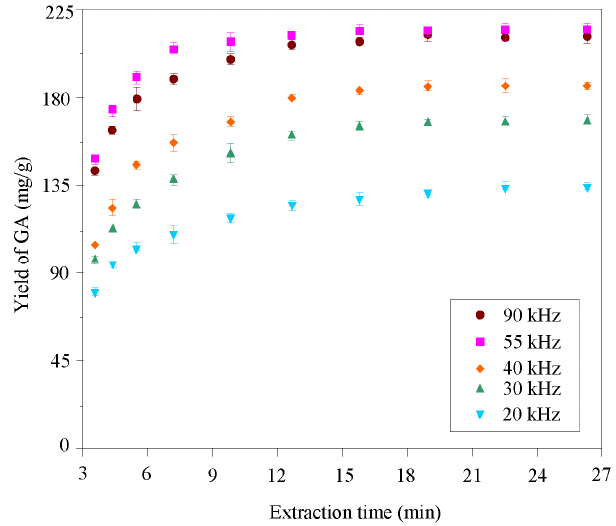
Figure 2. Evolution of extraction yields of glycyrrhizic acid with different ultrasonic frequencies at an extraction temperature of 25 °C and ultrasonic power of 125 W.